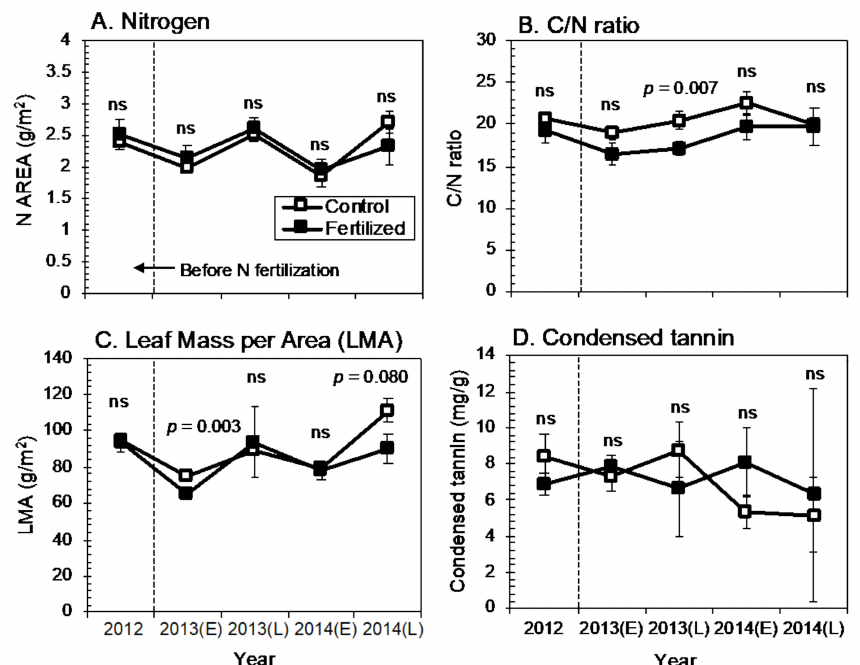
Figure 1. Changes in leaf nutrients of alder trees. ( A ) Nitrogen content, ( B ) C/N ratio, ( C ) leaf mass per area (LMA), and ( D ) condensed tannin in the leaves of alder trees at the control (empty boxes, n = 5) and fertilized (filed boxes, n = 5) sites from 2012 (before N fertilization) to 2014. E and L indicate early and late seasons. Each point is mean ± SE and the p -values are the results of t -tests (ns, p > 0.05).